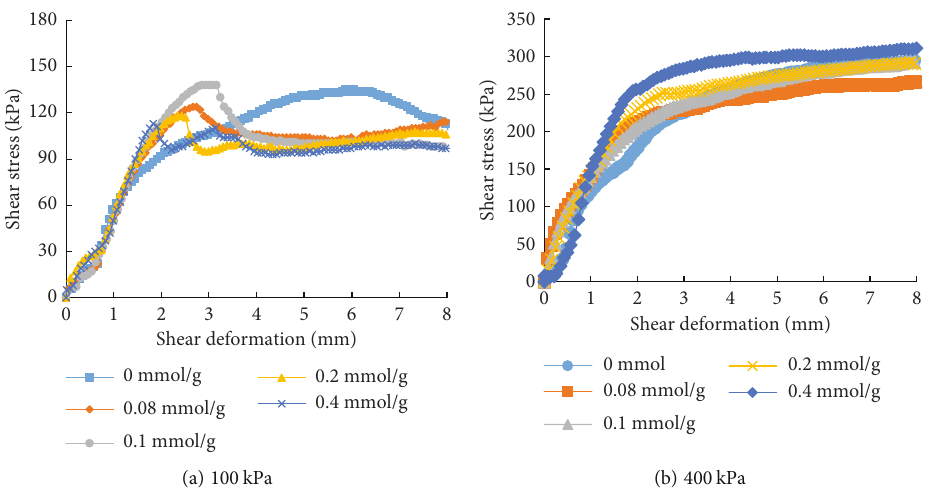
Figure 11: Stress-strain curve of hydroxyl aluminum-modi fi ed soil.